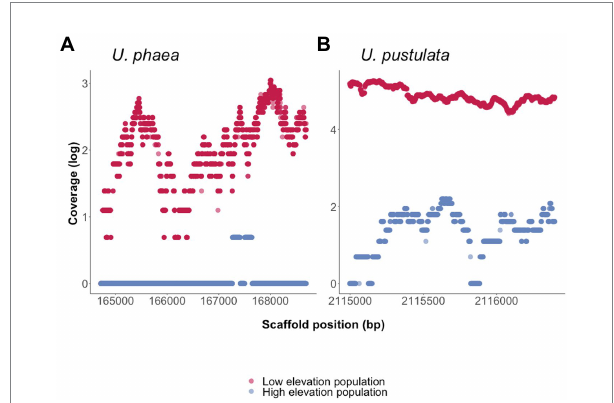
FIGURE 2 Presence/absences of orthologs in four de novo sequenced genomes of U. phaea and U. pustulata were verified by assessing the scaffold coverage in the warm adapted (low elevation) and the cold adapted population (high elevation) respectively. (A) Coverage of ortholog in U. phaea : High coverage in warm adapted (low elevation) population and no coverage in high elevational population. (B) Coverage of ortholog in U. pustulata : High coverage in warm adapted (low elevation) population.